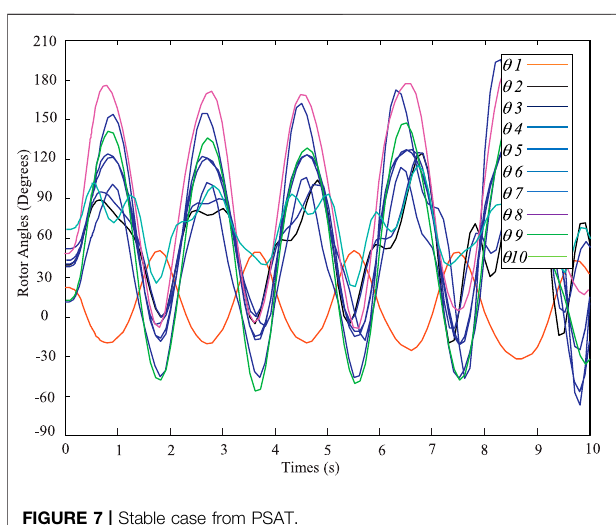
FIGURE 7 | Stable case from PSAT.